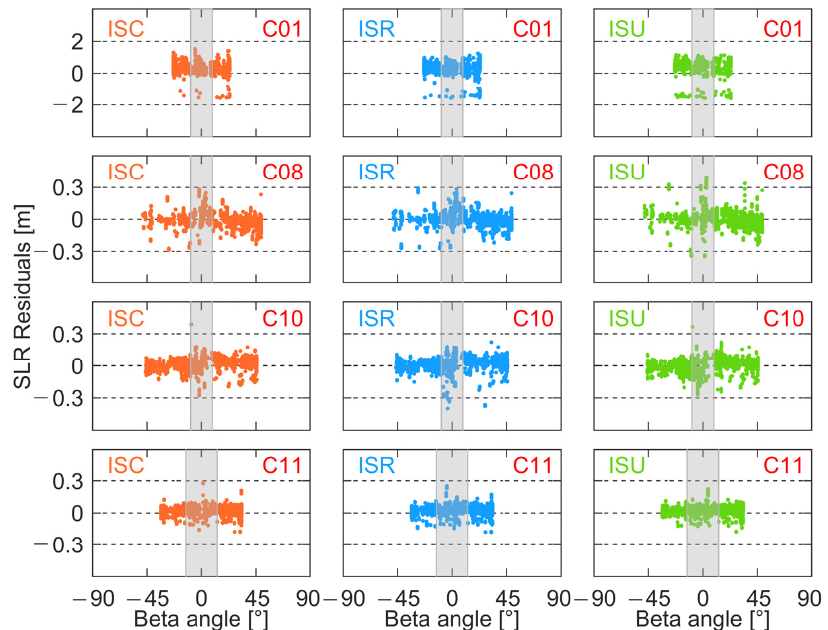
Figure 15. SLR residuals of BDS-2 satellites based on three types of iGMAS B1I/B3I orbits versus beta angle .